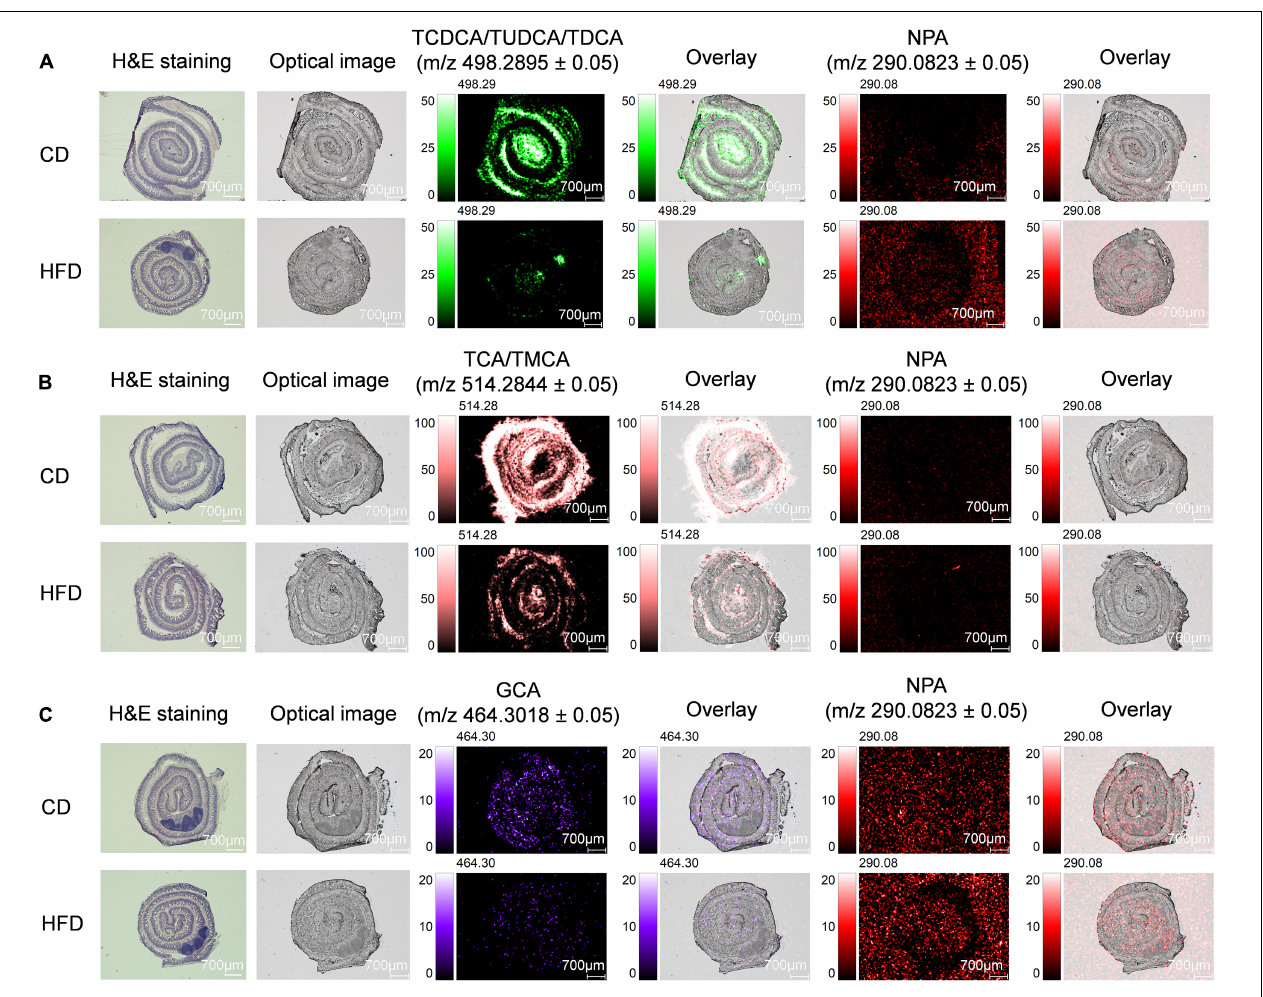
FIGURE 3 | MS imaging-based visual mapping profiles of BAs distributed within regions of ileum. MS ion images representing spatial distributions of NPA ( m/z 290.0823 ± 0.05) and the identified BAs at TCDCA/TUDCA/TDCA m/z 498.2895 ± 0.05 (A) , TCA/TMCA m/z 514.2844 ± 0.05 (B) and GCA m/z 464.3018 ± 0.05 (C) for the whole section of mouse ileum (Scale bars: 700 µ m). Overlay: Overlay of each MS ion image and optical image. All ion images were normalized to the 9AA matrix signal. Abbreviation: CD, control diet group; HFD, high-fat diet